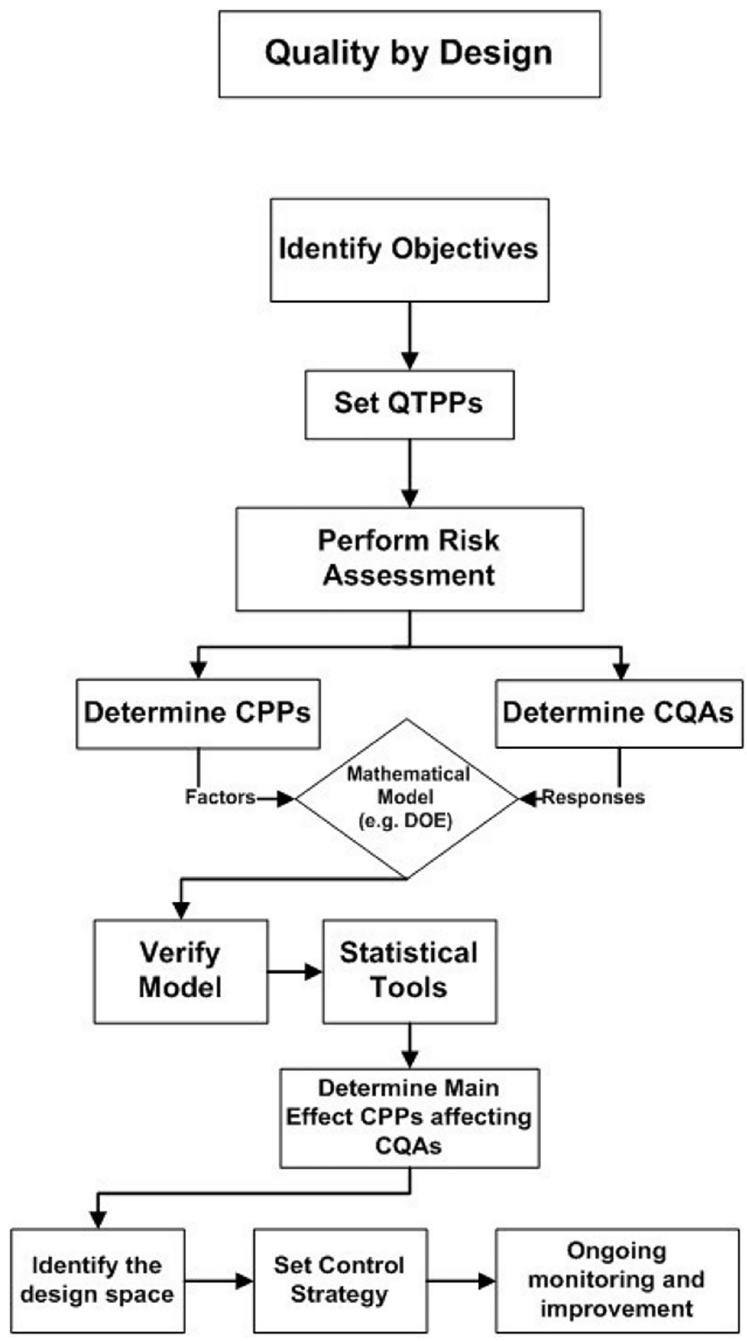
Fig 1. Flow chart outlining the elements of QbD (QTPP: Quality targeted product profile, CPPs: Critical process parameters, CQAs: Critical quality attributes, DOE: Design of experiments).